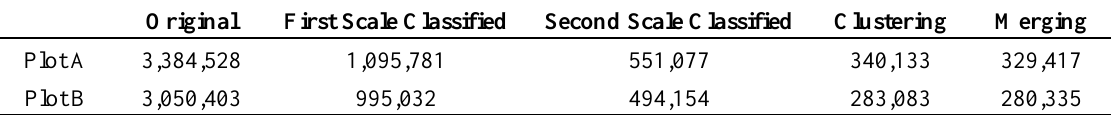
Table 3. Points counts after different